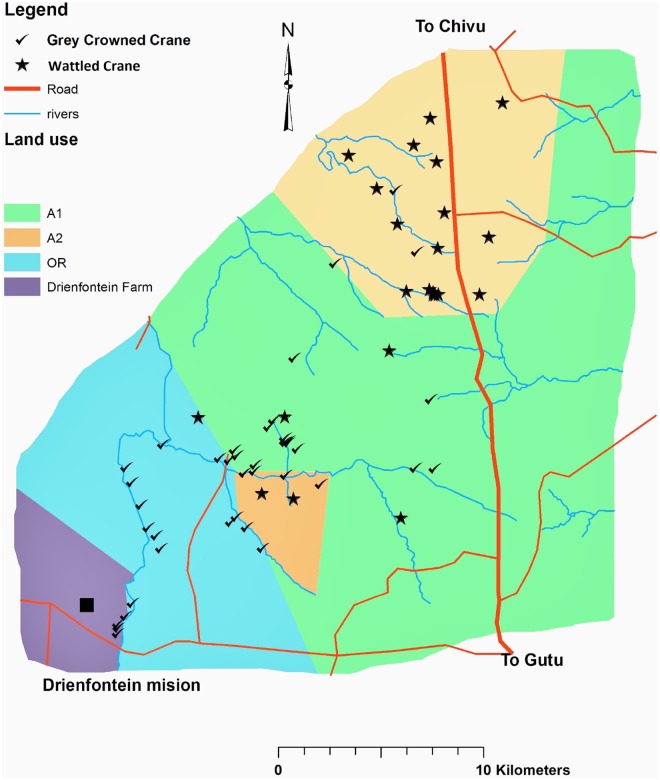
Locations of crane sightings in the Driefontein Grasslands IBA, Zimbabwe.Where A1 = the self contained small scale commercial farms of 30 to 40 ha per household, A2 = large scale commercial agriculture farms of > 50 ha per household and OR = Old Resettlement, villagized agriculture farms of < 5 ha per household with communal grazing land. Source: [2].